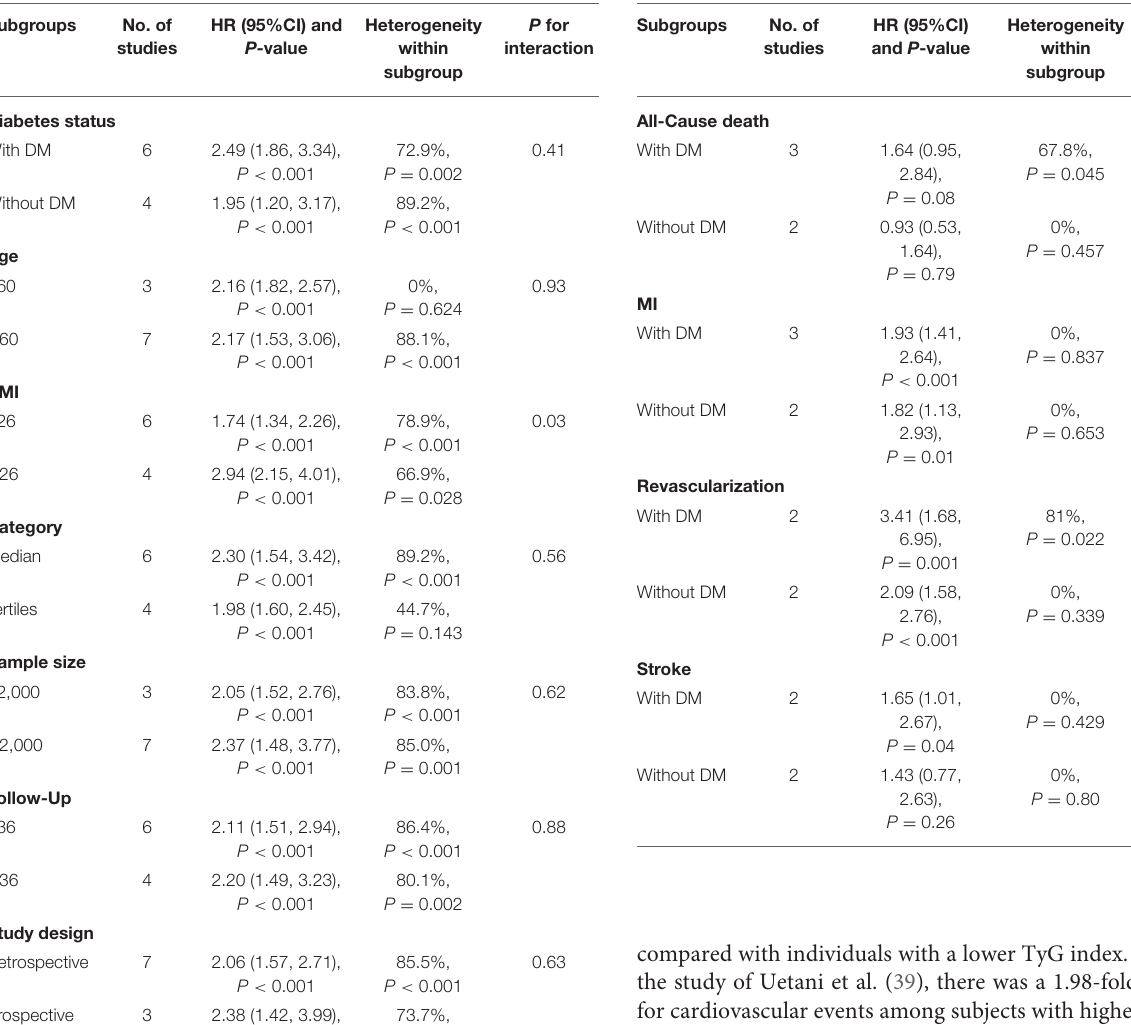
TABLE 3 | Subgroup analyses of the primary outcome. TABLE 4 | Subgroup analyses of secondary